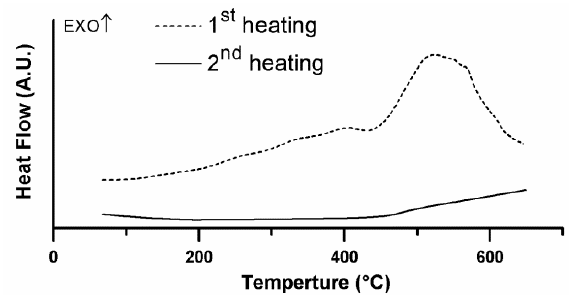
Figure 5. DSC curves of the sample milled during 10 h.